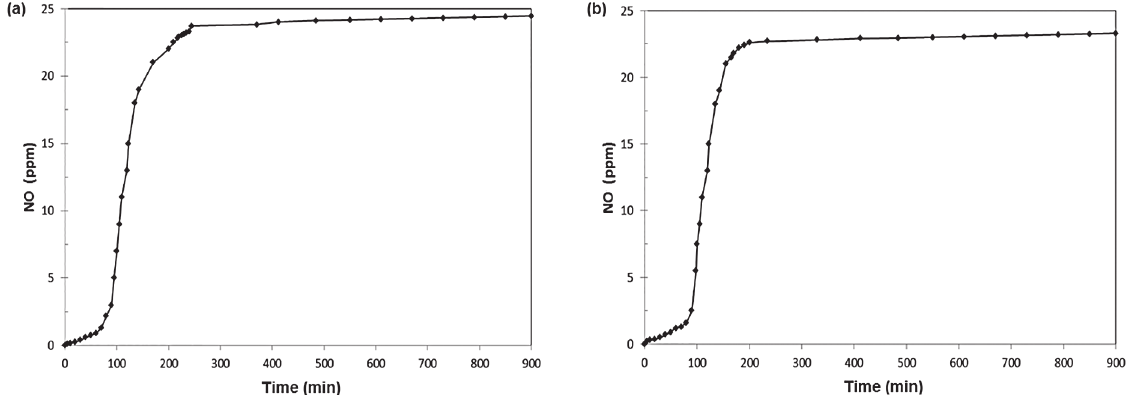
Figure 9 - Evolution of NO adsorption of samples (a) AVF 1 and (b) AVF